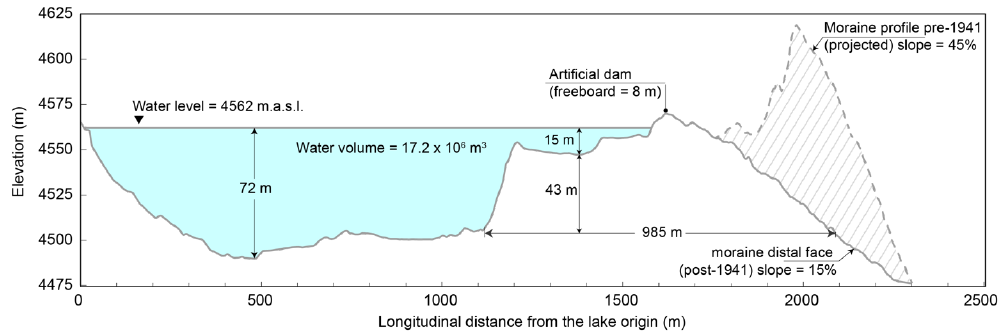
Figure 4. Longitudinal profile of Lake Palcacocha and its terminal moraine (factor of vertical exaggeration of 5). The moraine profile before the 1941 GLOF exhibited width-to-height ratios of 6, while the reshaped moraine after 1941 shows width-to-height ratios of 14 and gentler slopes of 15% (after Rivas et al., 2015).